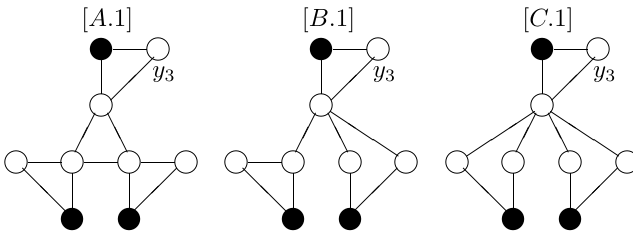
Fig. 23: Extensions of the cases [ A ] , [ B ] , and [ C ] for a maximum backbone tree of type